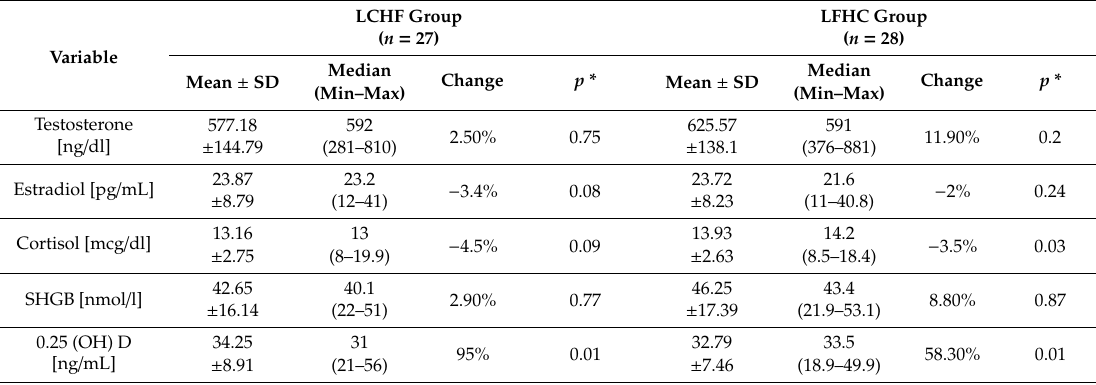
Table 5. Mean and median of the levels of hormones and SHGB after the intervention, and the changes in the levels of hormones and SHGB in both